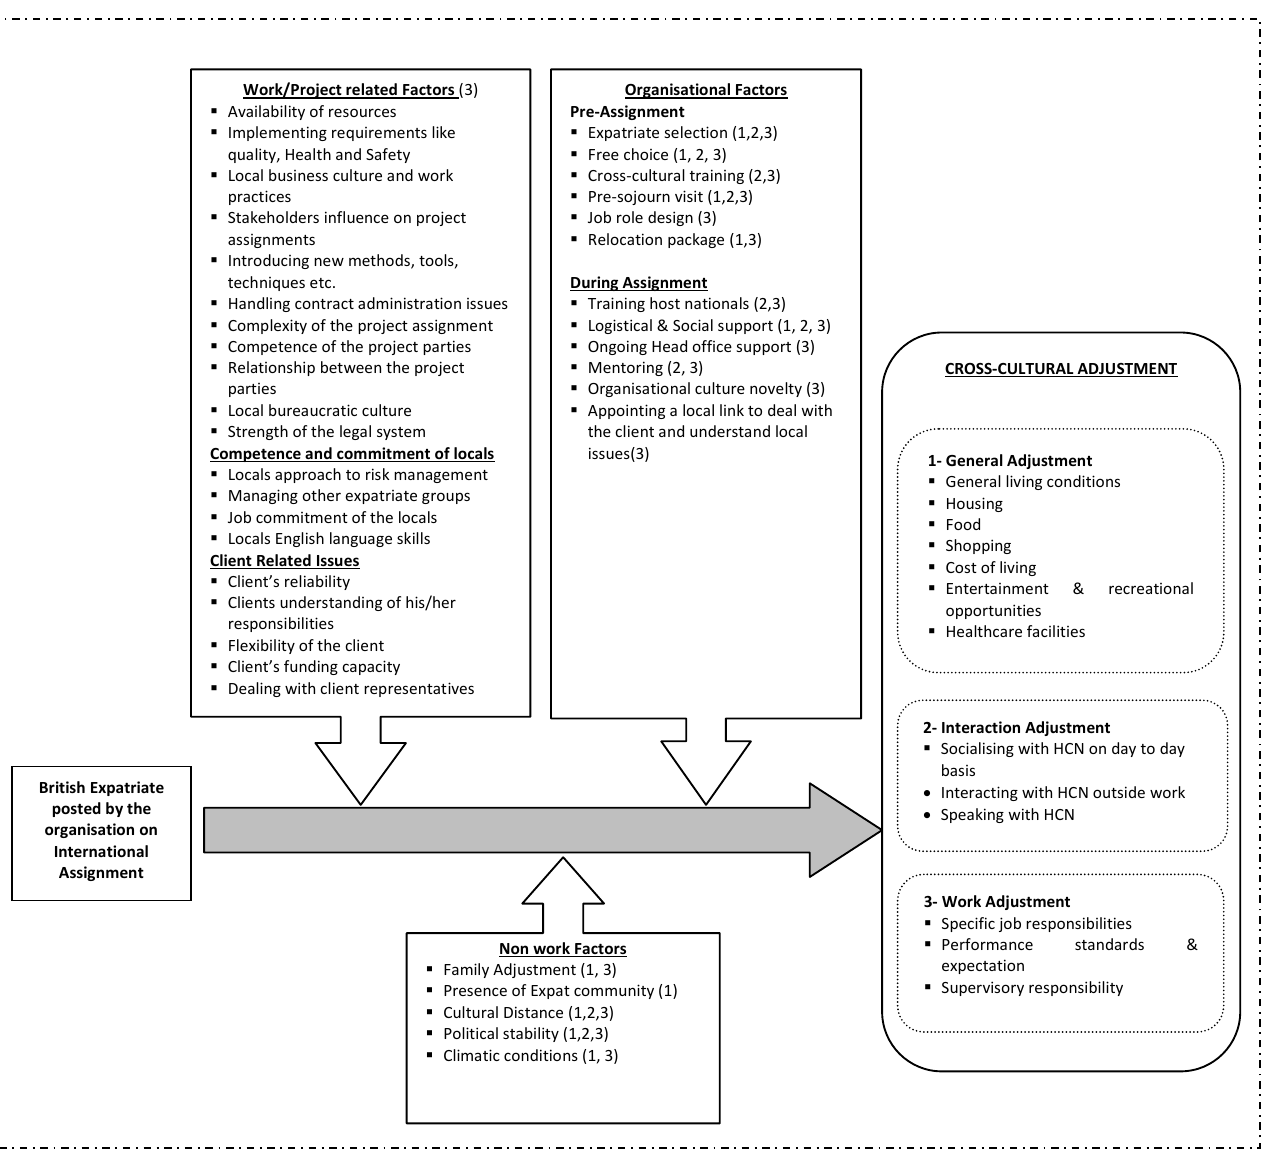
Figure 2 Framework for Cross-cultural Adjustment on International Assignments (The numbers in the brackets indicate the numbered facet of adjustment to which the variable